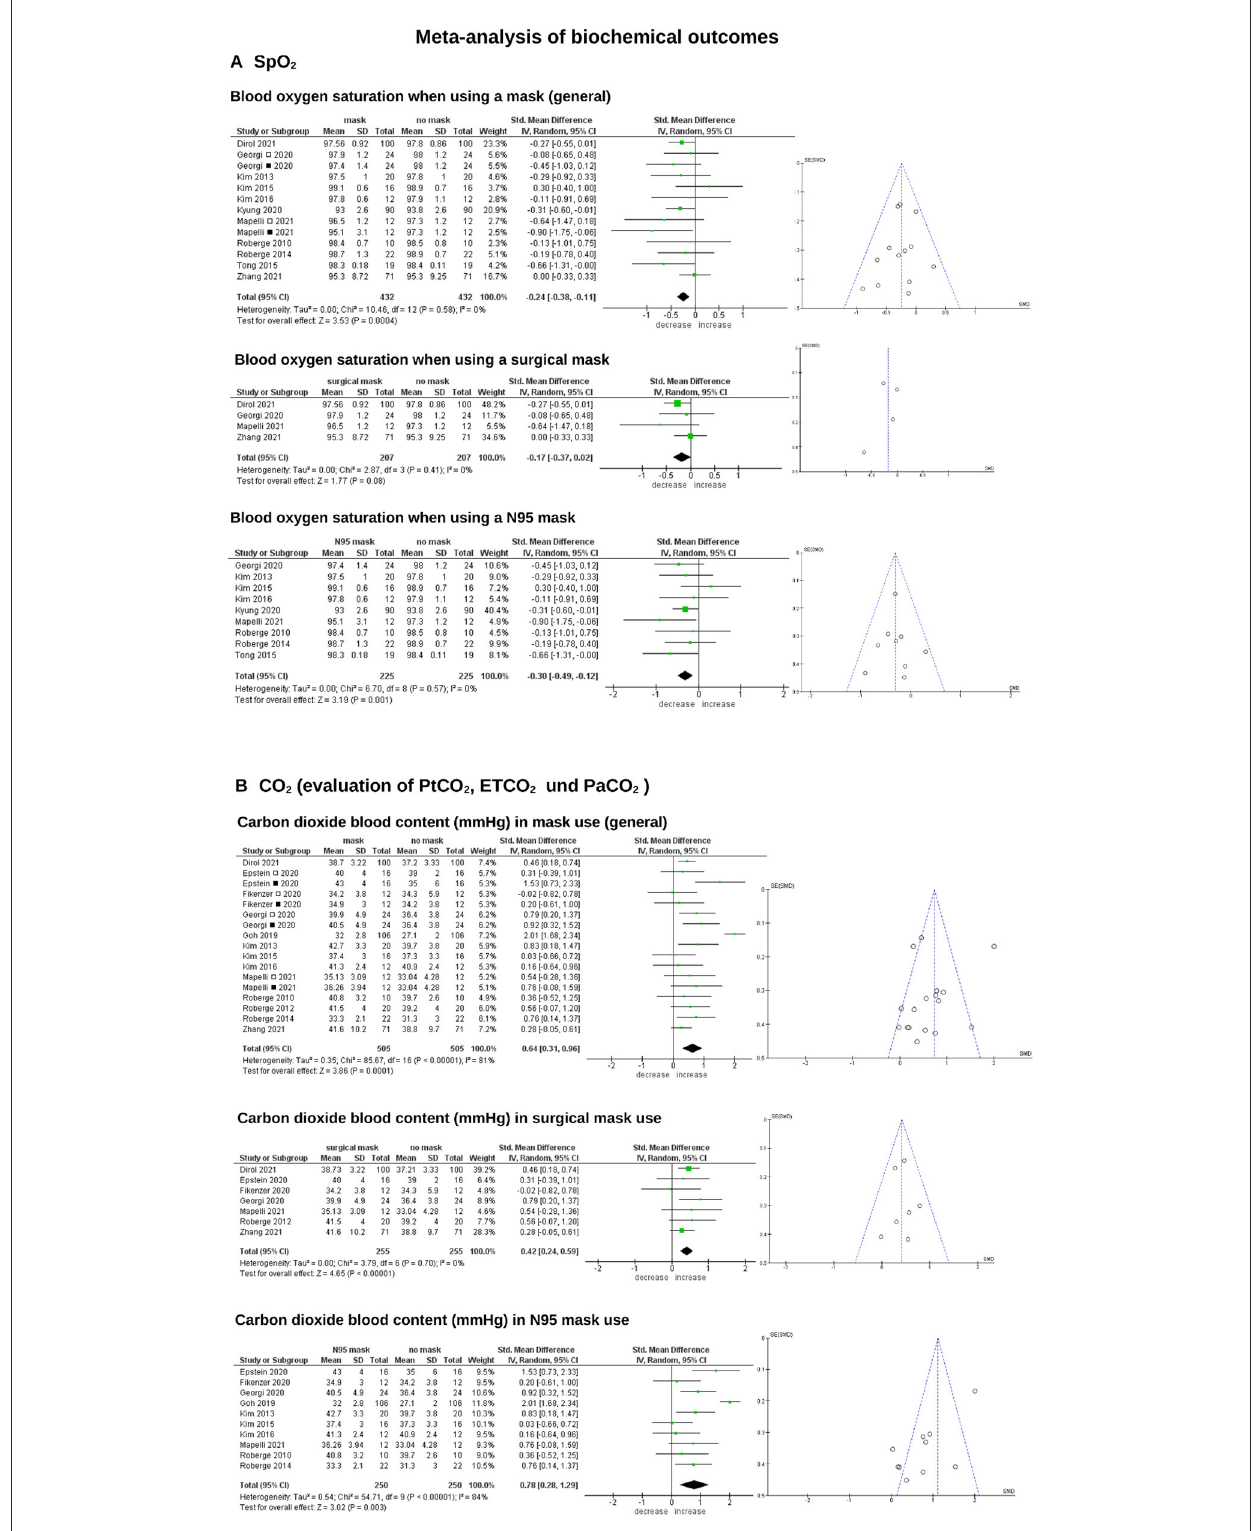
FIGURE2 Forest (left) and funnel plots (right) of meta-analysis of blood oxygenation and blood carbon dioxide outcomes while wearing a face mask. All face mask types are initially considered together, later subgroups (surgical and N95) are evaluated. If studies examine two different mask types in parallel, the corresponding studies are marked: (cid:3) surgical mask (cid:4) N95 mask. (A) Blood oxygen is significantly lowered in mask use. In the subgroup = = analysis this could also be found for N95 mask use. From the pooled analysis, it seems, that N95 mask may be responsible for a larger SpO 2 drop than surgical masks. In studies evaluating both conditions (surgical and N95 mask) the N95 mask yielded always lower O 2 -values than the surgical masks. (B) In the pooled analysis, blood carbon dioxide (PtCO 2 , ETCO 2 , and PaCO 2 ) is significantly elevated in mask use. This could be found for general mask use and in the subgroup analysis for surgical mask, and also for N95 mask use. In studies evaluating both conditions (surgical and N95 mask) the N95 mask yielded always higher CO 2 -values than the surgical